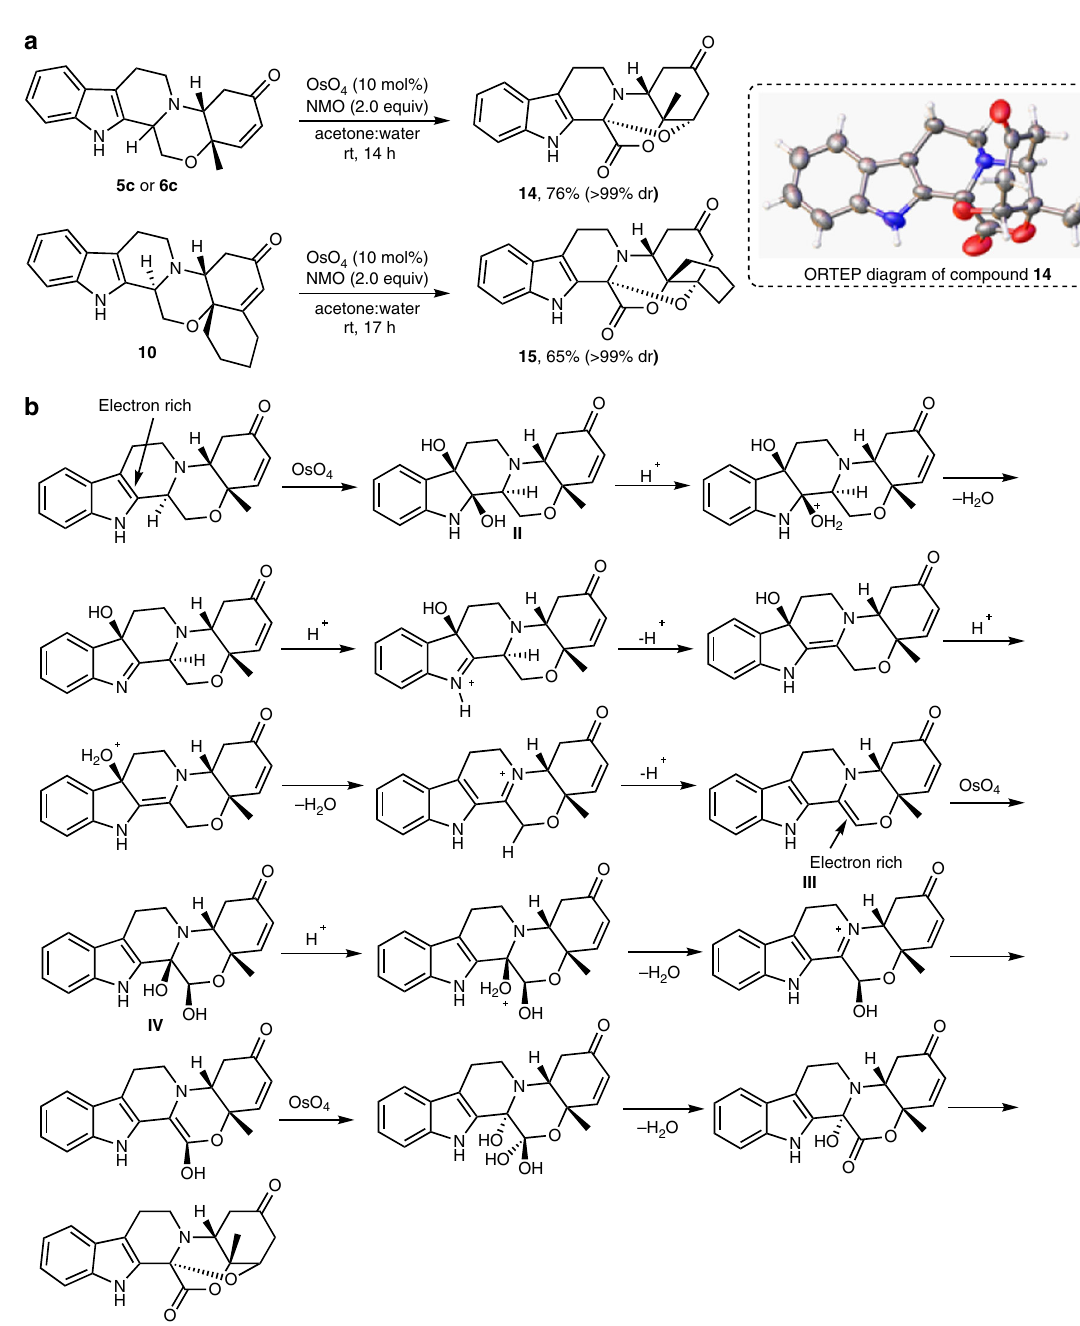
Fig. 5 Post-pairing transformations of octahydroindolo[2,3-a]quinolizines. a OsO 4 -catalyzed synthesis of the compounds 14 and 15 . b A proposed mechanism for the OsO 4 catalyzed formation of compound